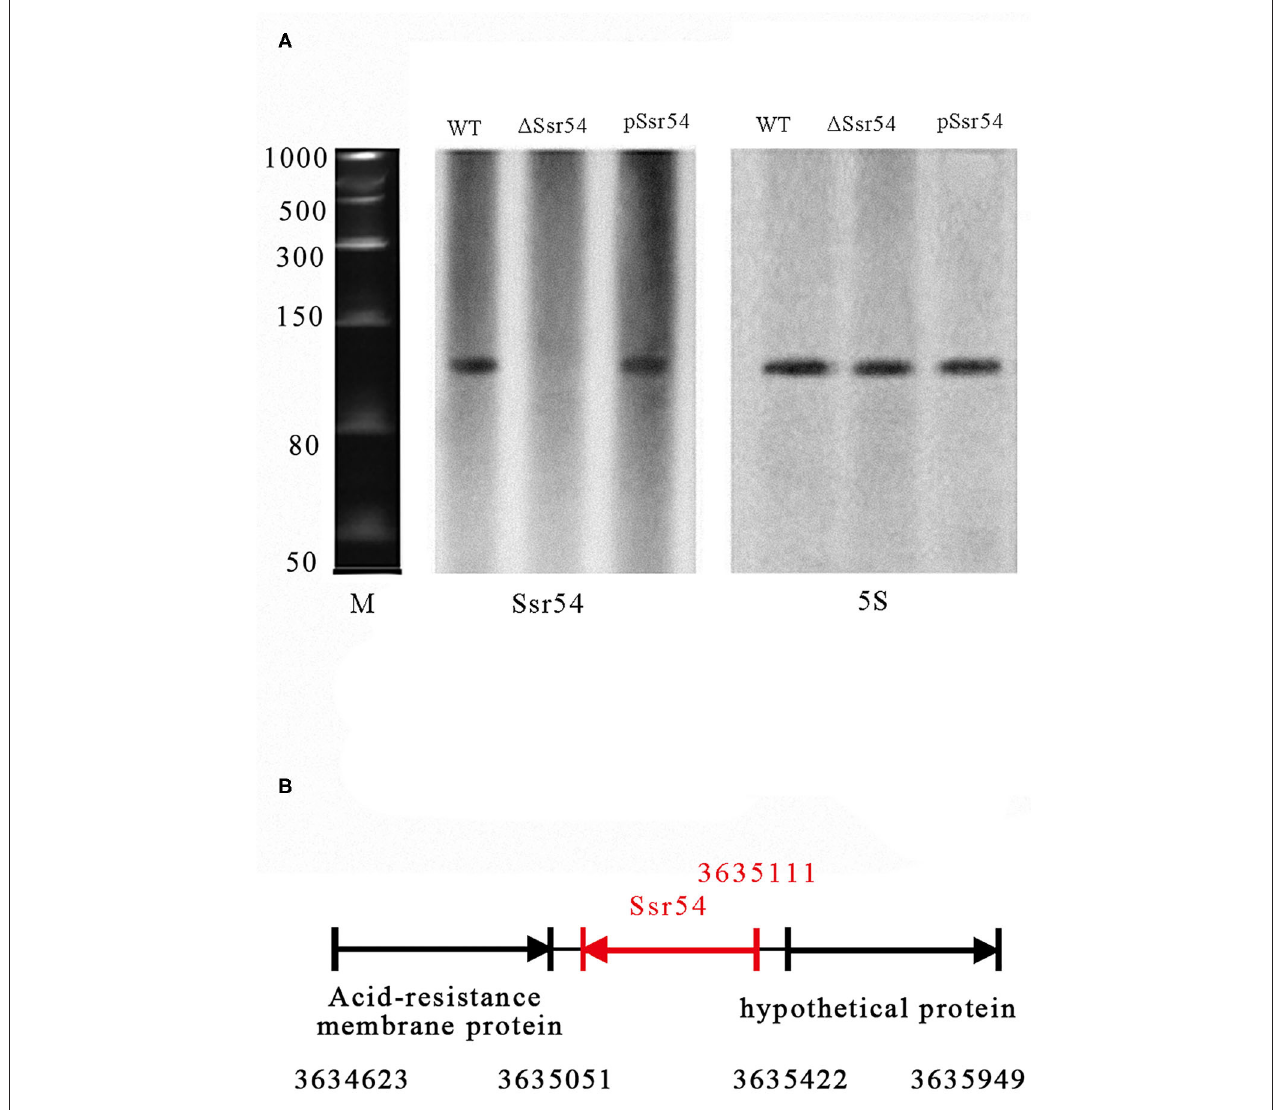
FIGURE 1 | Experimental verification and expression of S. flexneri small RNAs (sRNAs). (A) Northern blot of the novel sRNA ( Ssr54 ) and 5S rRNA in S. flexneri wild-type, Ssr54 mutant, and Ssr54 complement strains. Ssr54 expression in the S. flexneri strains grown to logarithmic growth phase was verified by Northern blotting; (B) Ssr54 genomic position in S. flexneri was assessed via 5 ′ rapid amplification of cDNA